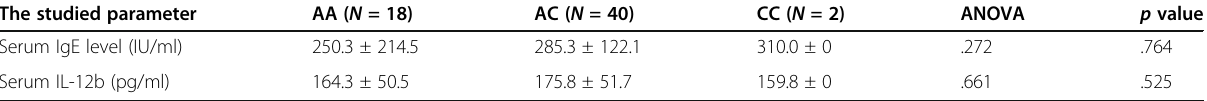
All parameters represented as mean and SD Table 9 Effect of IL-17A gene polymorphism on IgE and IL-17A serum levels in domestic mites' allergic patient The studied parameter